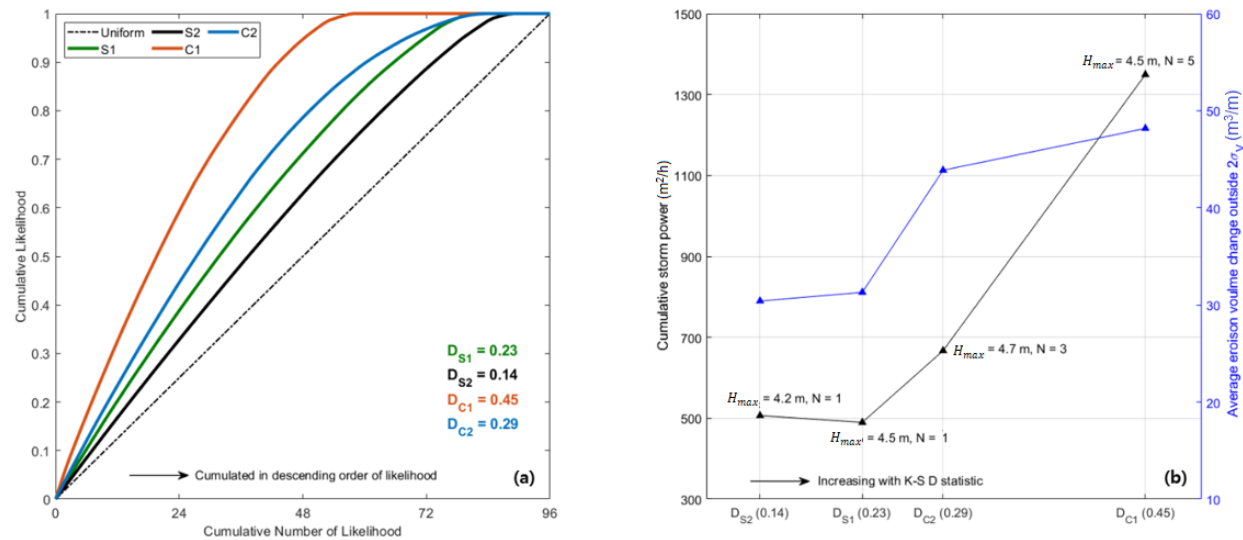
Figure 9. ( a ) Cumulative likelihood distributions in each storm condition with the K–S D statistic; and ( b ) model sensitivity based on K–S D to the cumulative storm power and the average erosion volume change outside the two standard deviations ( ∆ V 2 σ ); H max and N indicate the maximum storm wave height during each storm event and number of storms in a cluster, respectively; higher K–S D indicates a higher model sensitivity to parameter